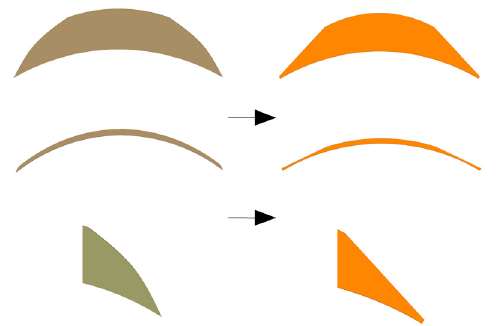
Figure 3. Equivalent model of chamber.